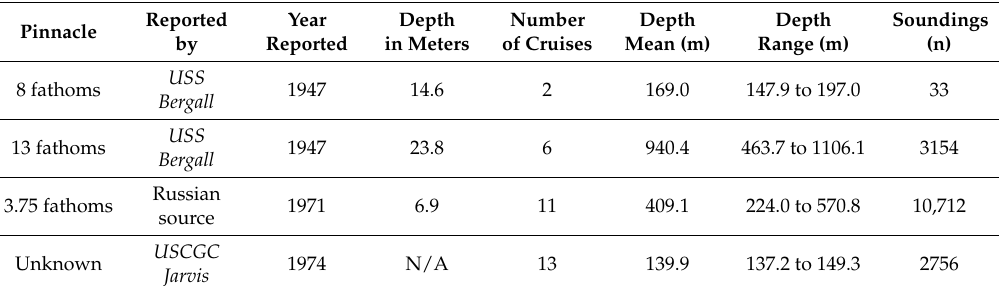
Table 4. We summarized the soundings from numerous different cruises used for our compilation at four sites near Zhemchug Canyon where pinnacles are reported as potential navigational hazards on NOS navigational Chart